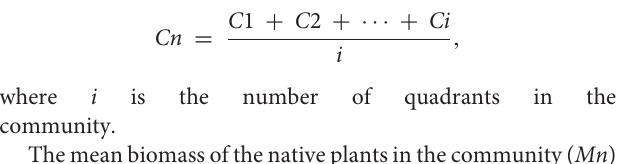
represent the actual community structure. For each